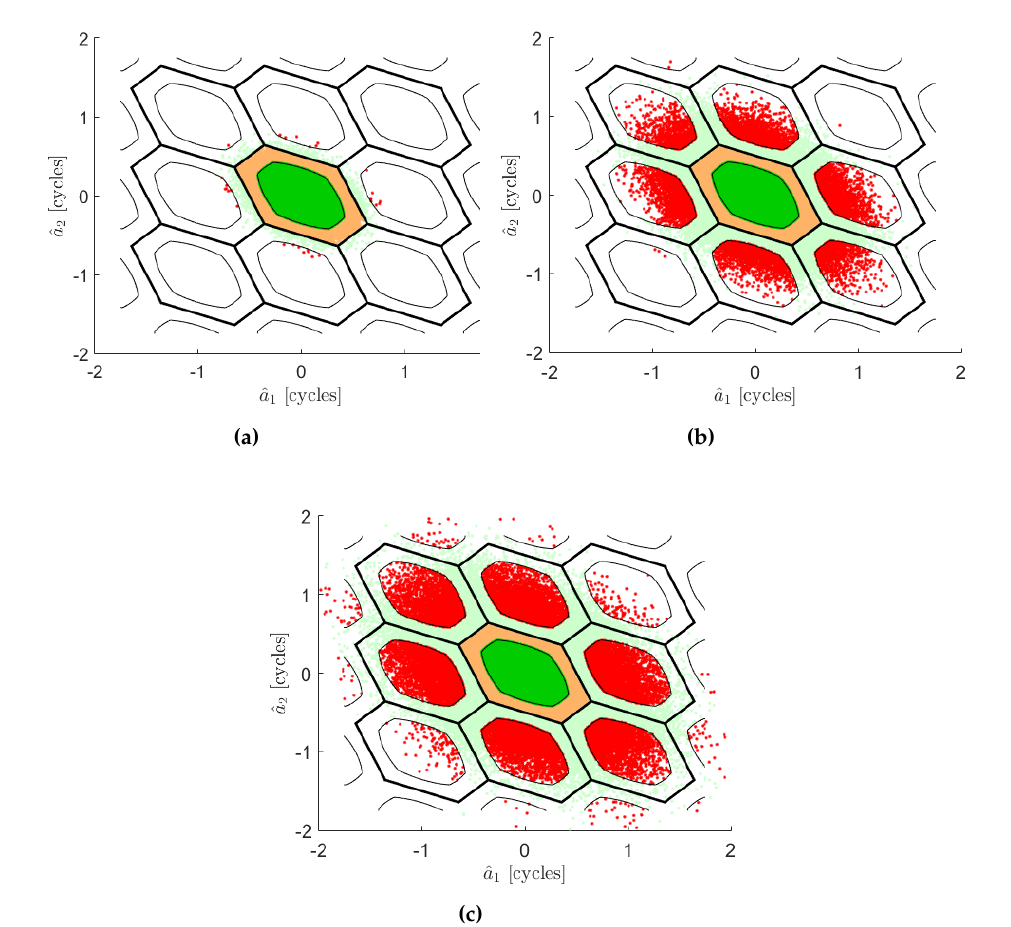
Figure B1. The spread of float ambiguities with P f , ILS increases. ( a ) Low P f , ILS ; ( b ) Higher P f , ILS ; ( c ) Even higher P f , ILS